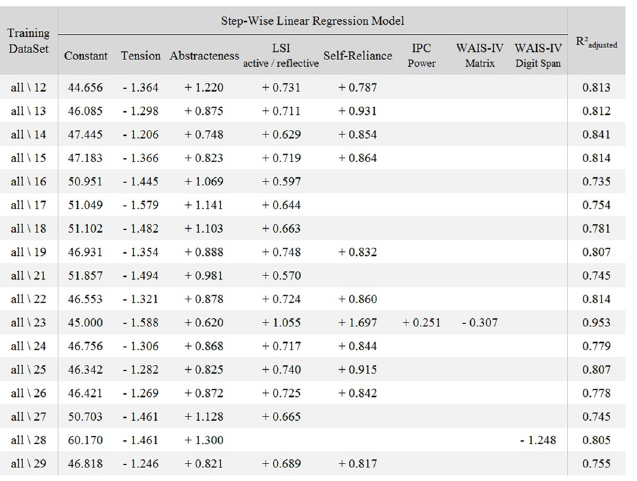
Fig 6. The 17 models generated from leave-one-subject-out cross validation process. The coefficients for each factor that was included in the model generated from the training datasets ( all n XX meaning that the training dataset was composed of all the participants except XX) are detailed in each row.